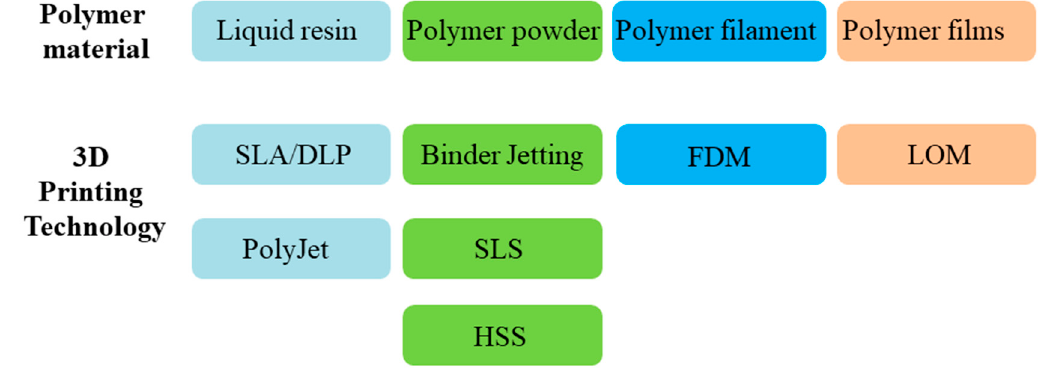
Figure 2. Polymer materials used with specific building methods in additive manufacturing (AM).